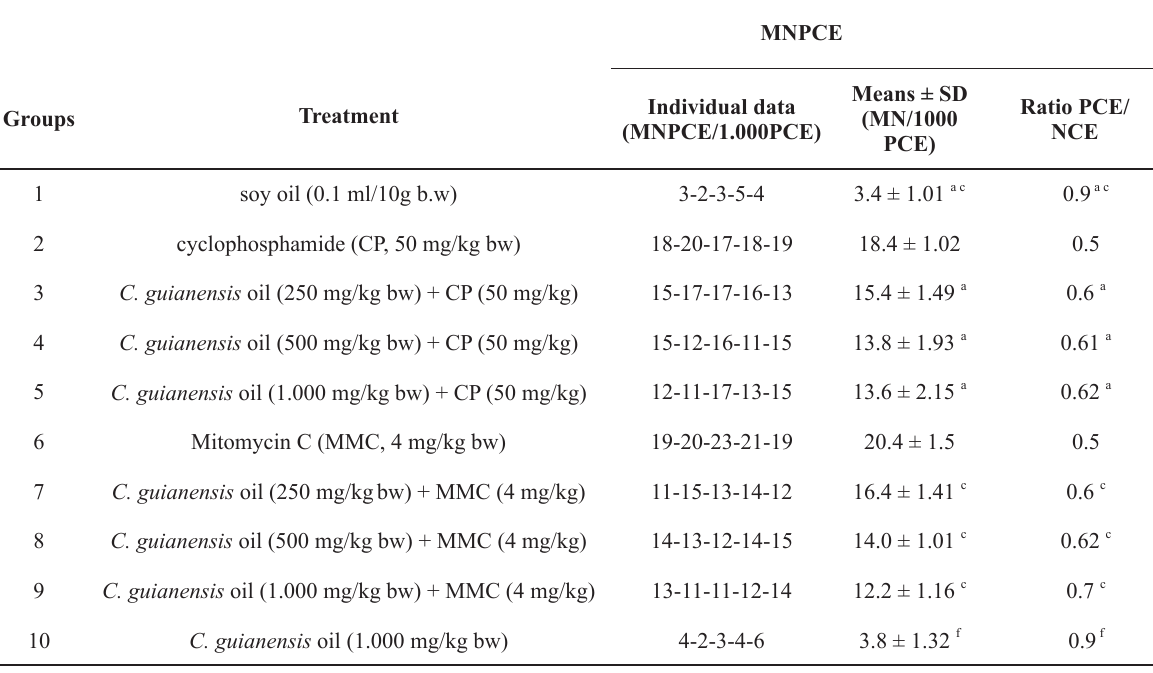
Frequency of micronucleated polychromatic erythrocytes (MMPCE) and polychromatic erythrocytes/normochromatic erythrocytes (PCE/NCE) ratio in mice bone marrow cells treated with different doses of the C. guianensis oil and co- treated with cyclophosphamide(CP) or mitomycin C (MMC) and their respective controls.